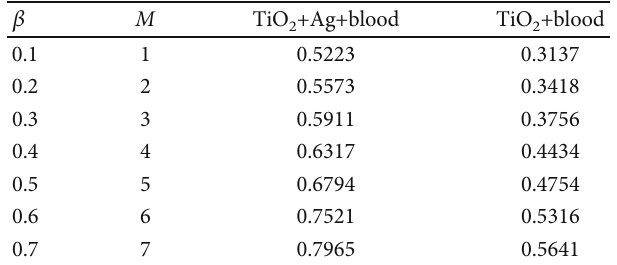
Table 1: The inspiration of M and β on skin friction coe ffi cient.